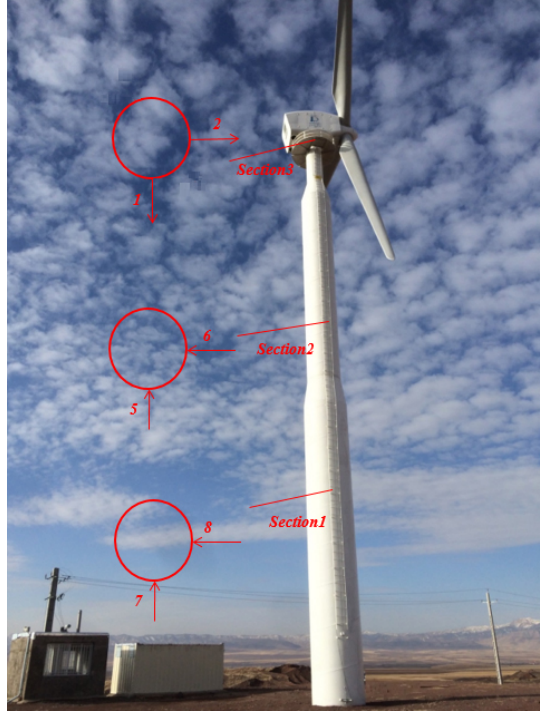
Figure 4. The sensor placement layout on the wind turbine tower, based on GA.